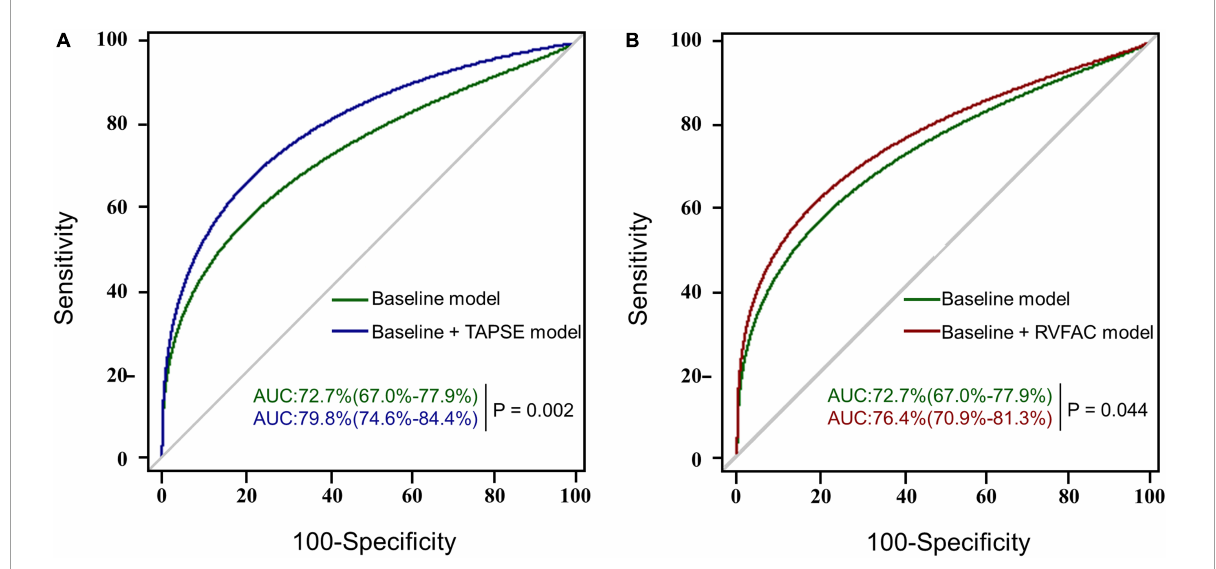
FIGURE4 The AUC analysis for the prediction of postoperative moderate to severe AKI. RVFAC, right ventricular fractional area change; TAPSE, tricuspid annular plane systolic excursion; AUC, area under the receiver operating characteristic (ROC) curve with a p -value for the difference between different models. (A) The ROC curves of the baseline model (green) and baseline model + TAPSE (blue) for the prediction of moderate to severe AKI with the AUC and corresponding 95% confidence intervals. (B) The ROC curves of the baseline model (green) and baseline model + RVFAC (red) for the prediction of moderate to severe AKI.